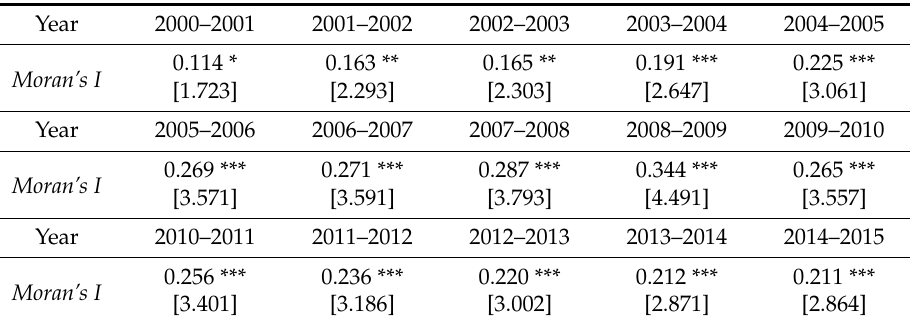
Table 4. Global Moran’s I of provincial